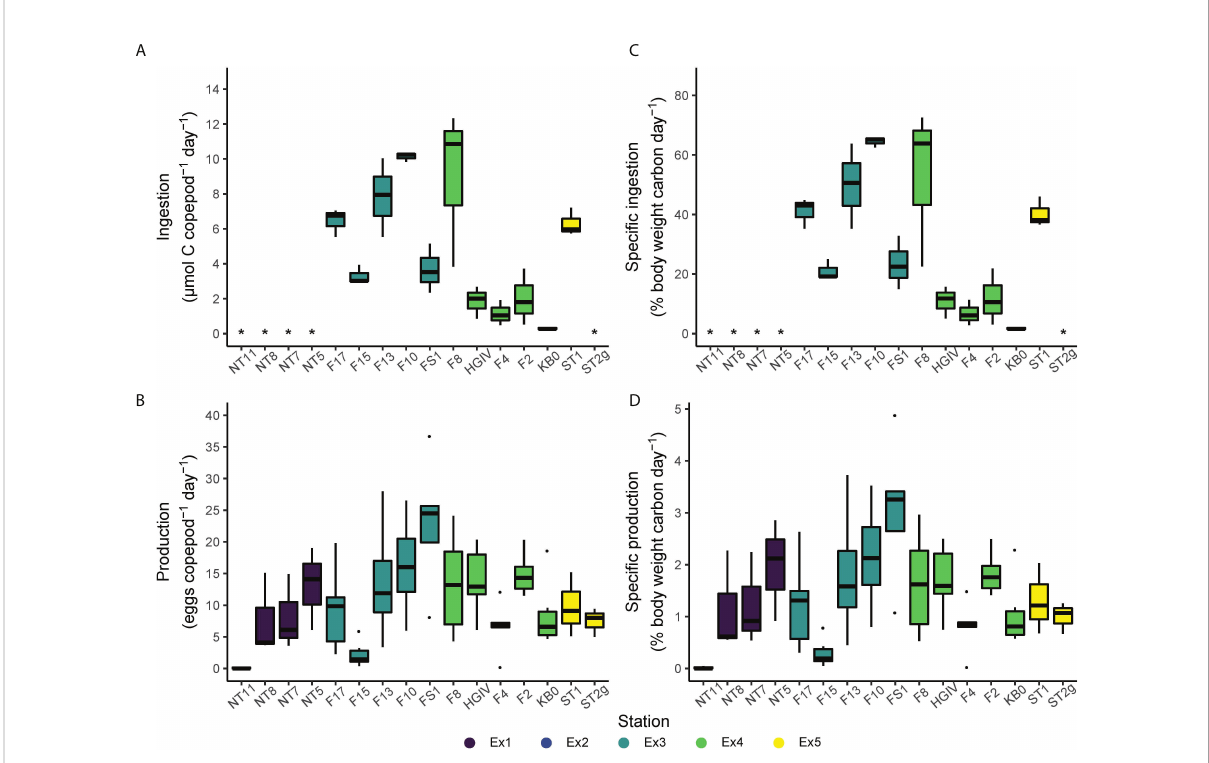
FIGURE 4 Total ingestion (A) , speci fi c ingestion (B) , total egg production (C) , and speci fi c egg production (D) by Calanus fi nmarchicus across the Fram Strait. The mid-line represents the median, the box the upper and lower quartiles, whiskers the range, and black points the outliers. Speci fi c ingestion and production were converted from a fraction to a percentage for these fi gures. * indicates where the parameter was not